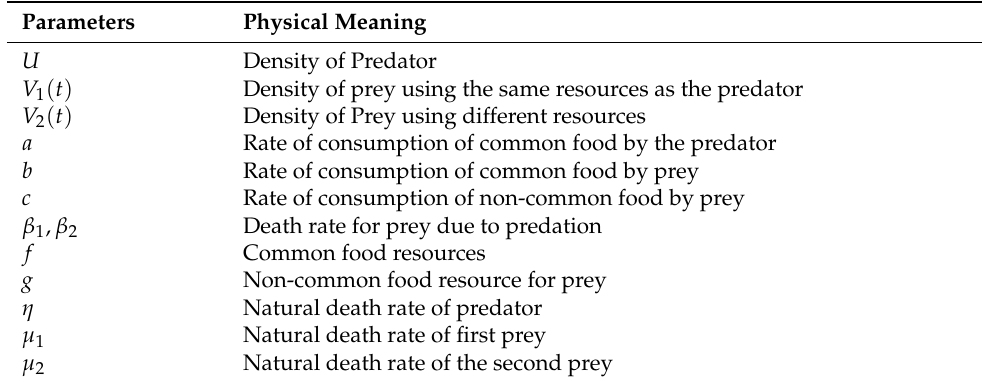
Table 1. Breif description of variables and